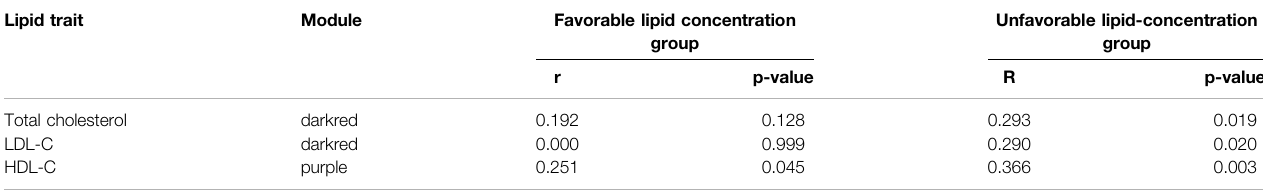
TABLE2| Pearsoncorrelation(andp-value)betweenmoduleeigengenes(frommodulesassociatedwithlipidtraits)andlipidconcentrationswherelipidtraitsweredividedin clinically favorable vs . unfavorable lipid concentration groups (i.e., high total cholesterol, high LDL-C, low HDL-C). Lipid trait Module Favorable lipid concentration